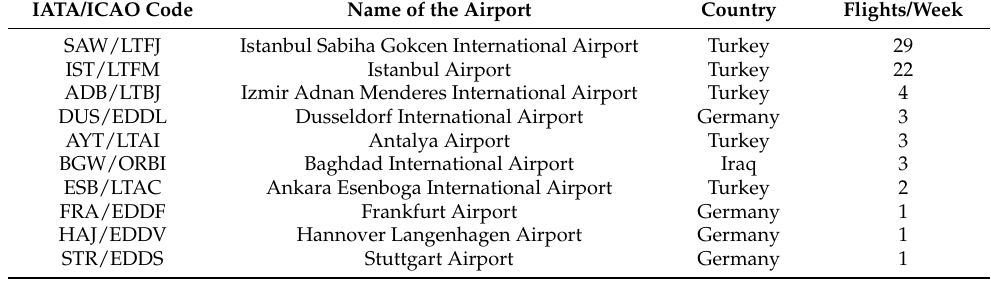
Table 7. Top routes from SZF/LTFH.